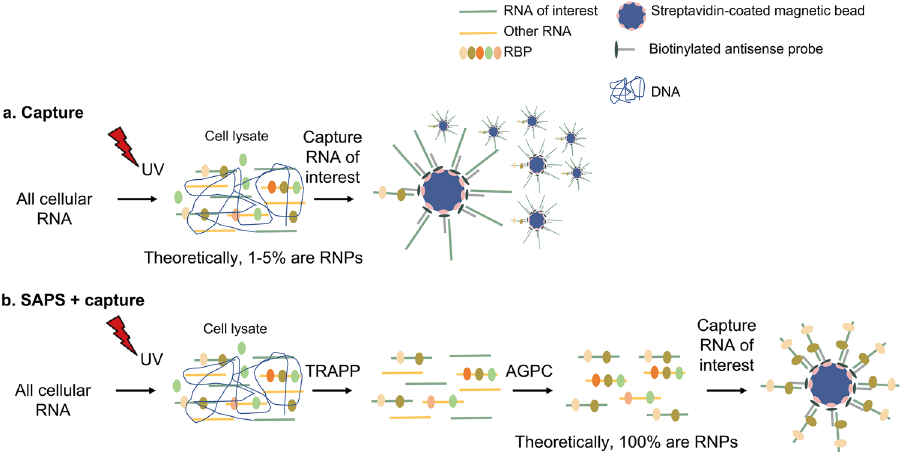
Figure 1. Schematic representing the gain in efficiency when combining a general RNP isolation with a specific RNP capture due to the removal of non-cross-linked RNA. Reworked picture from Van Ende et al. (2020) 18 ( a ) Most of the previously described specific RNA isolation protocols, capture RNA from the cross-linked lysate. ( b ) If the capture is performed on a pre-purified RNP sample, the protocol will have an increased efficiency of